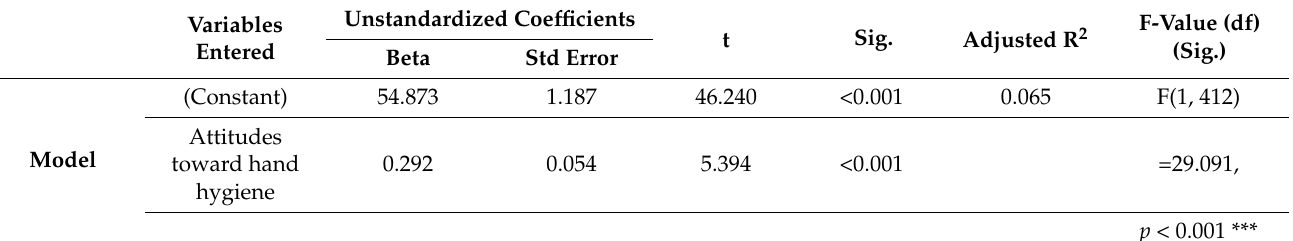
Table 7. The final model for predicting practice score regarding hand